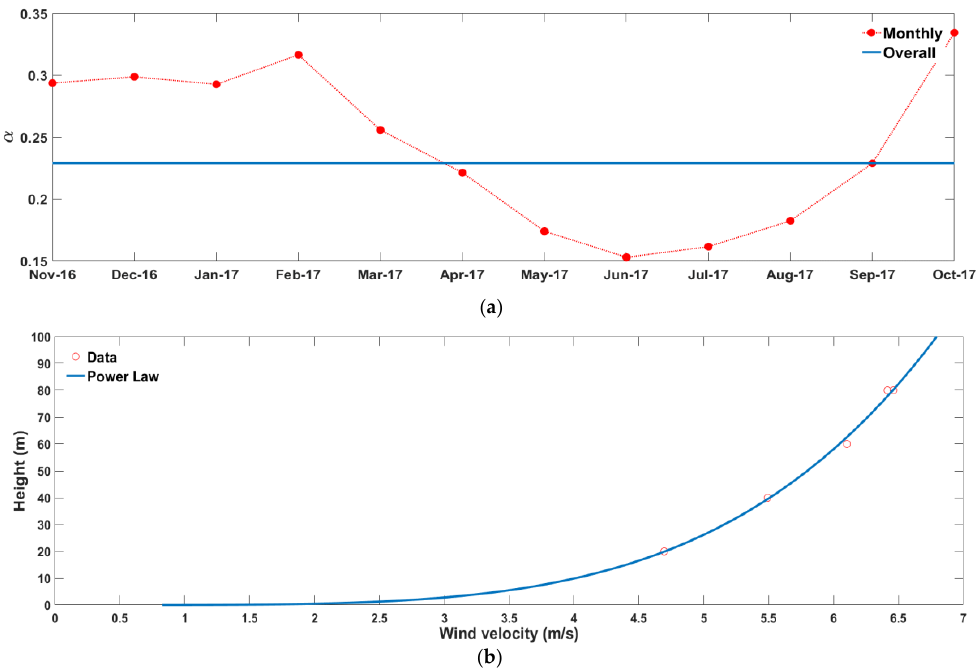
Figure 11. Monthly and yearly evaluation of shear exponent and shear profile for proposed site ( a ) monthly and overall values of alpha, ( b ) the Shear profile of site using power law for Sanghar site .